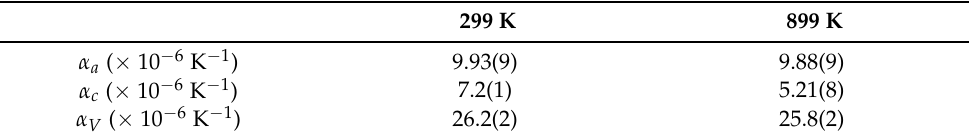
Table 1. Lattice and its volume thermal expansion coefficients of CrSi 2 at 299 K and 899